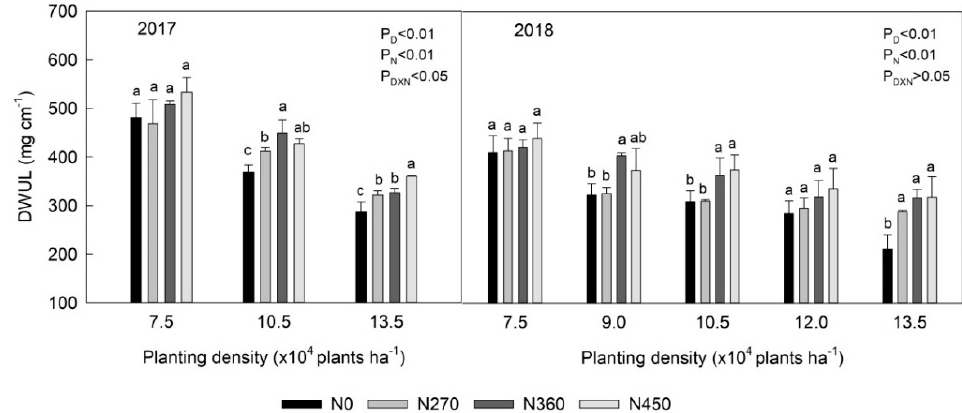
Figure 4. Effect of nitrogen application rate on the dry weight per unit length (DWUL) of the basal internodes of maize under drip irrigation at different planting densities.